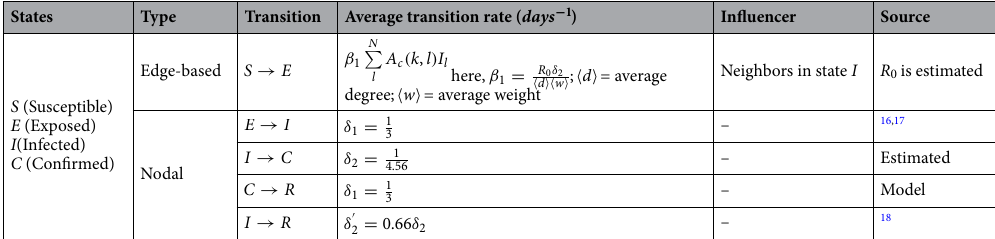
Table 1. Description of the susceptible-exposed-infected-confirmed (SEICR) epidemic